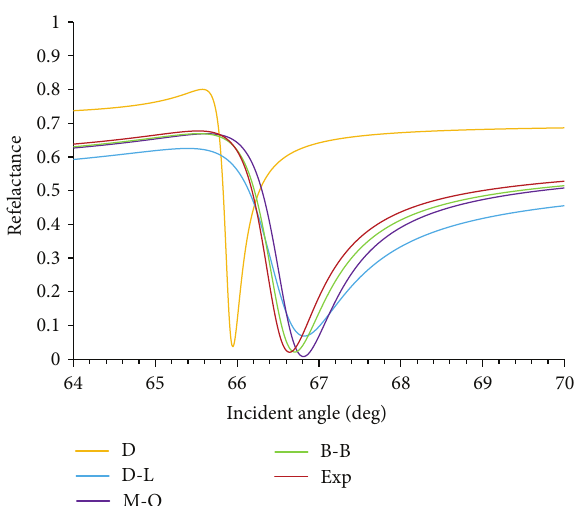
Figure 4: Reflectance versus incident angle of 30 ∘ to 70 ∘ , at 600 nm.